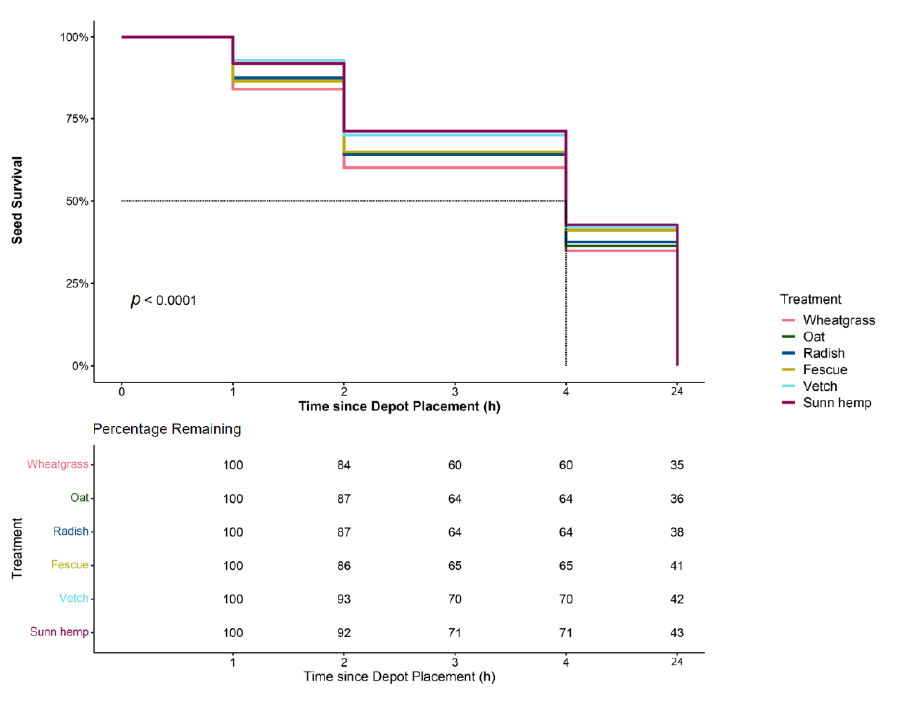
Table 1. p -values for the pairwise comparisons using log-rank test between seed types for the seed preference study ( n = 6770 total seeds).